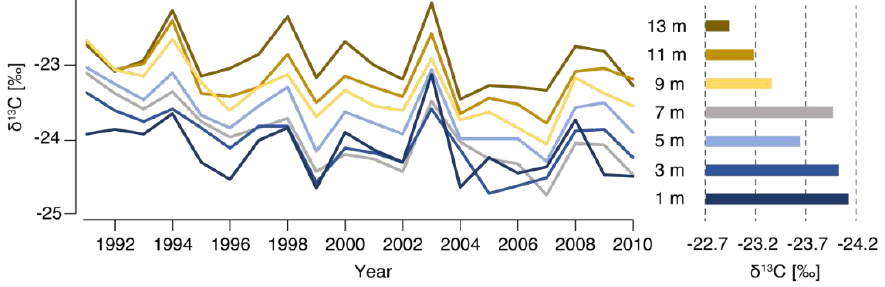
Figure 5. Longitudinal δ 13 C variability. Left panel shows the δ 13 C disc mean curves (DMCs), integrating the radii A-F at tree heights from 1 to 13 m. Right panel shows the average values at these heights.